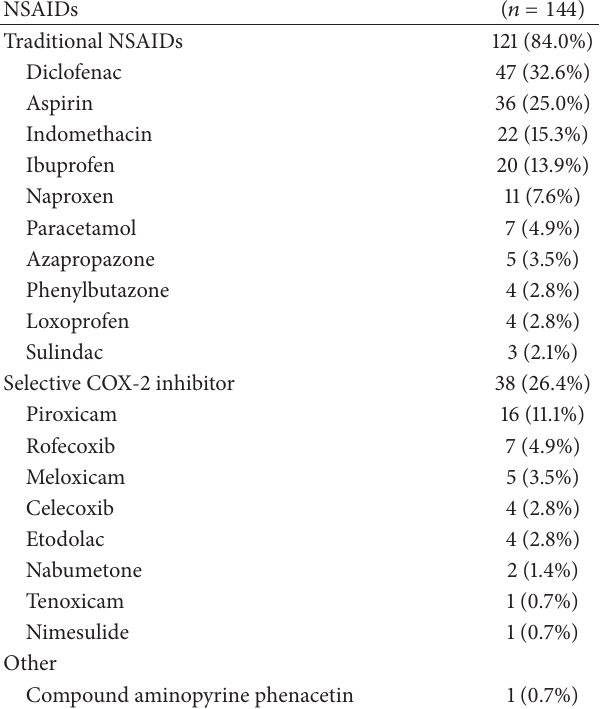
Table 2: Type of NSAIDs used in patients with NSAIDs-induced Figure 2: Location of diaphragm-like stricture. Postoperative ileum